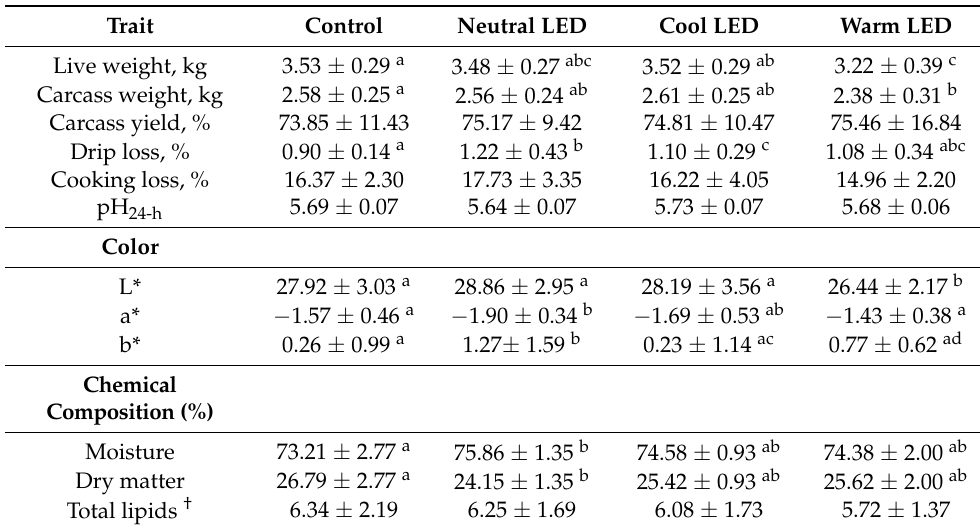
Table 2. Physical and chemical characterization of breast meat samples obtained from broilers exposed to different light